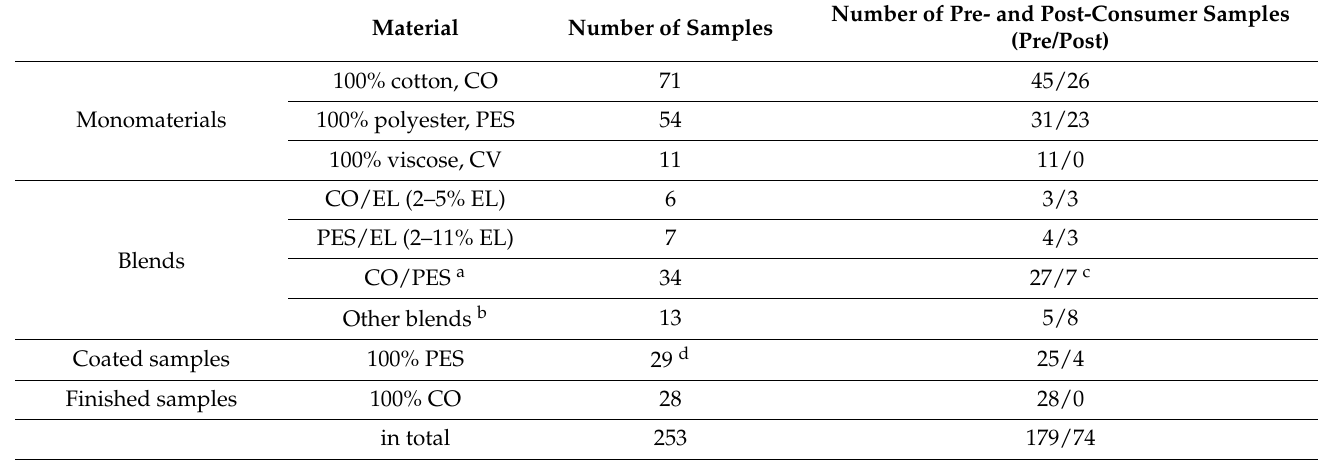
Table 3. Analysed